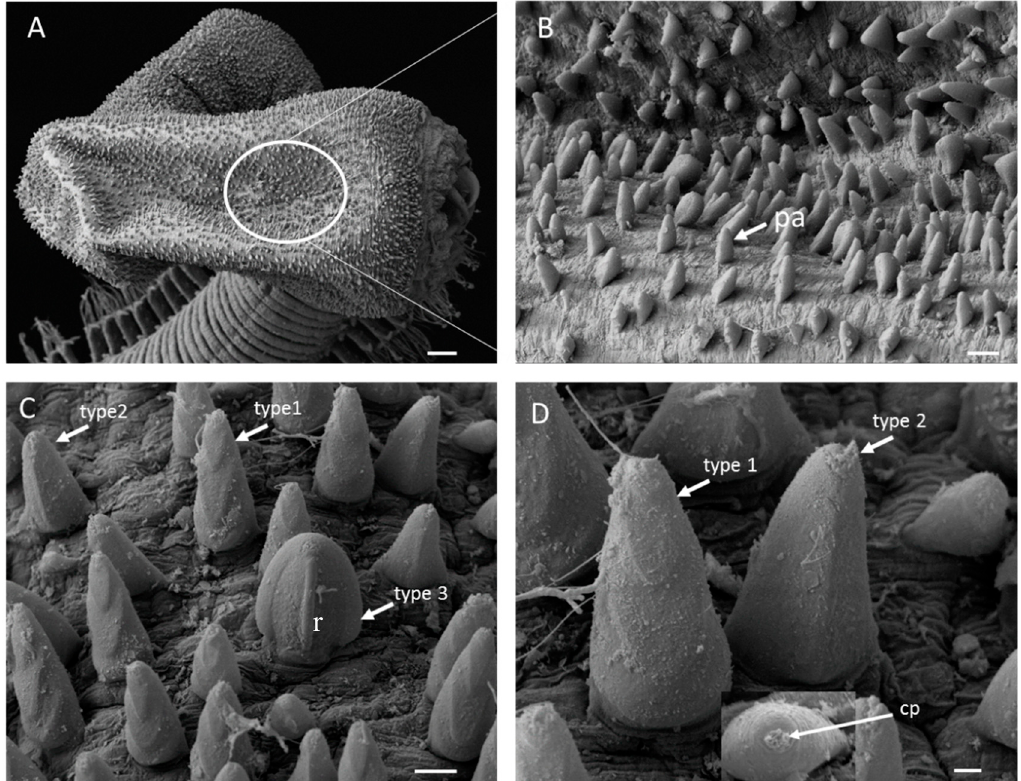
Figure 5. Glycera sheikhmujibi n. sp. SEM images of the ( A ) proboscis; ( B ) enlarged view of the proboscideal papillae; ( C ) posterior side view of type 1, type 2, and type 3 papillae; and ( D ) enlarged view of type 1and type 2 papillae. cp: ciliated pore, pa: papillae, r: ridge. Scale bars: A = 100 µm, B = 20 µm, C = 10 µm, and D = 2 µm.